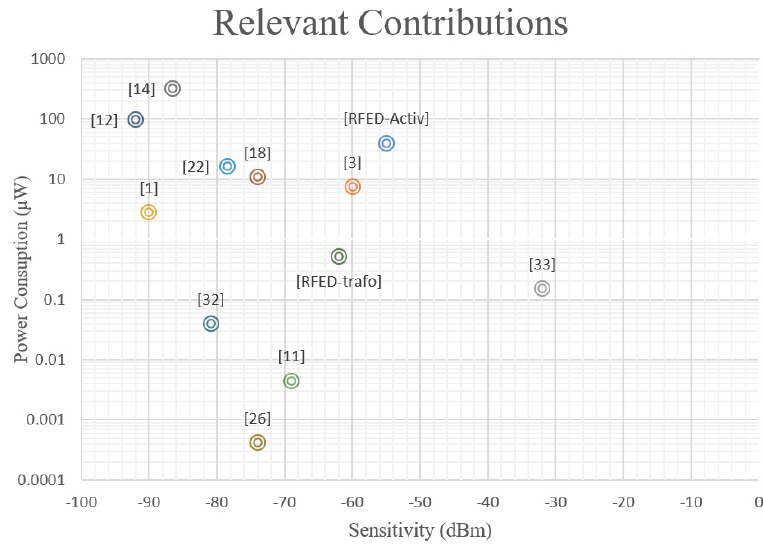
Figure 12. Representation of the performance of the proposed contributions along with some of the most relevant state-of-the-art works involving WuR design.